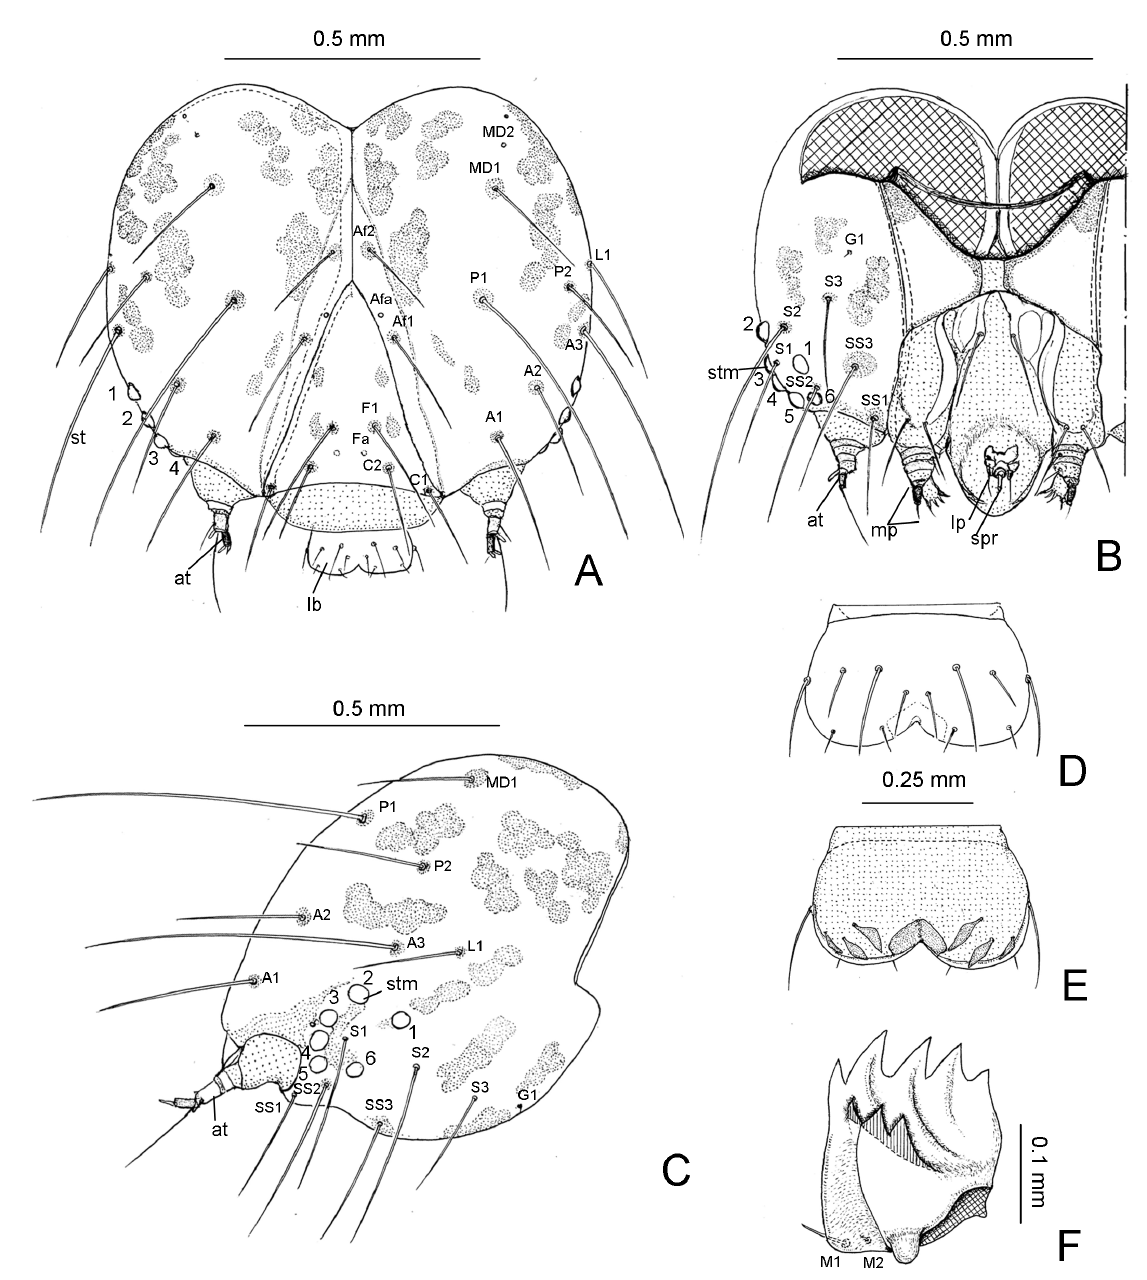
Fig. 5. Mature larval head of Tonza citrorrhoa Meyrick, 1905 (OPU-IN-LE2018IV0031|SK600, 0025|SK603, 0026|SK604). A . Head capsule, frontal view. B . Same, rear view. C . Same, lateral view. D . Labrum, frontal view. E . Same, rear view. F . Mandible, inner view. Abbreviations: A1, A2, A3 = anterior setae; Af1, Af2 = adfrontal setae; Afa = pore between setae Af1 and Af2; at = antenna; C1, C2 = clypeal setae; F1 = frontal seta; Fa: pore on the frons; L1 = lateral seta; lb = labium; lp = labial palpus; M1, M2 = mandibular setae; MD1, MD2 = microdorsal setae; MG1 = microgenal seta; mp = maxillary palpus; P1, P2 = posteriodorsal setae; S1, S2, S3 = stemmatal setae; spr = spinneret; SS1, SS2, SS3 = substemmatal setae; stm =